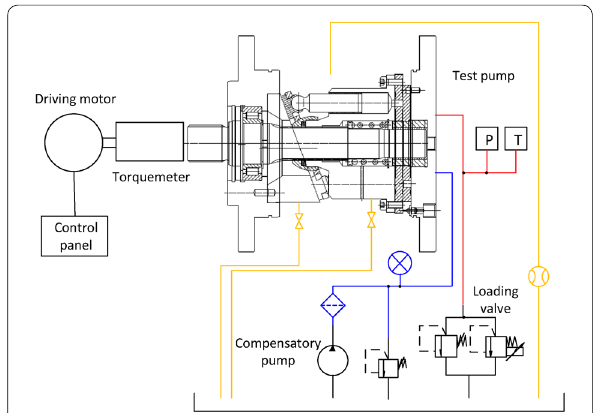
Figure 2 Schematic of the test system